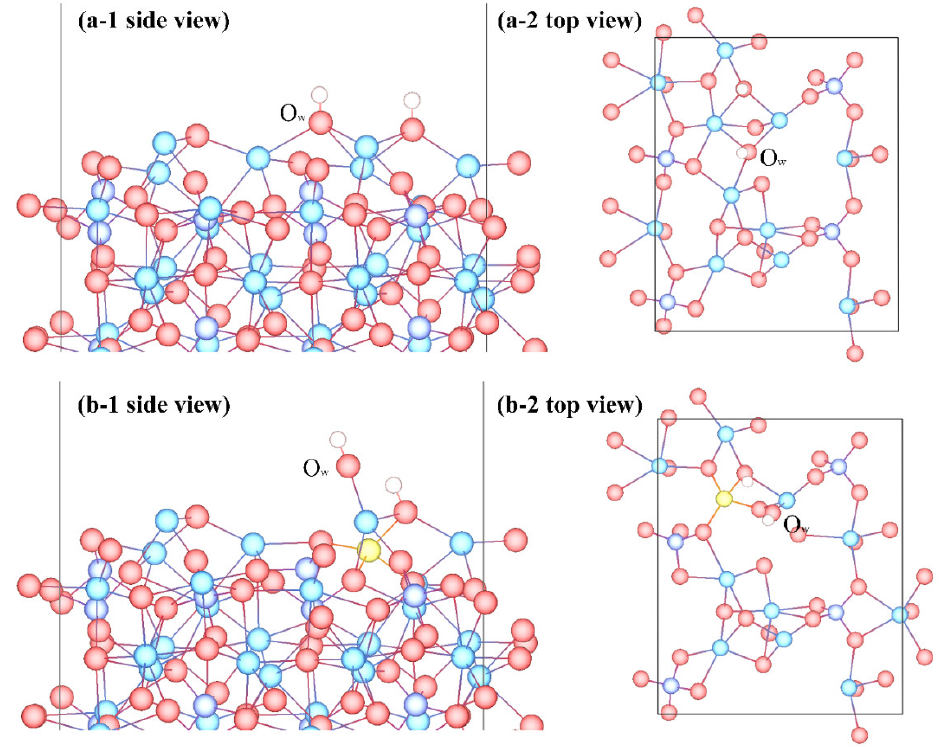
Figure 8. The dissociative adsorption configuration on the M3-C 3 S (111) surface of: ( a ) pristine surface, and ( b ) Mg-doped surface.